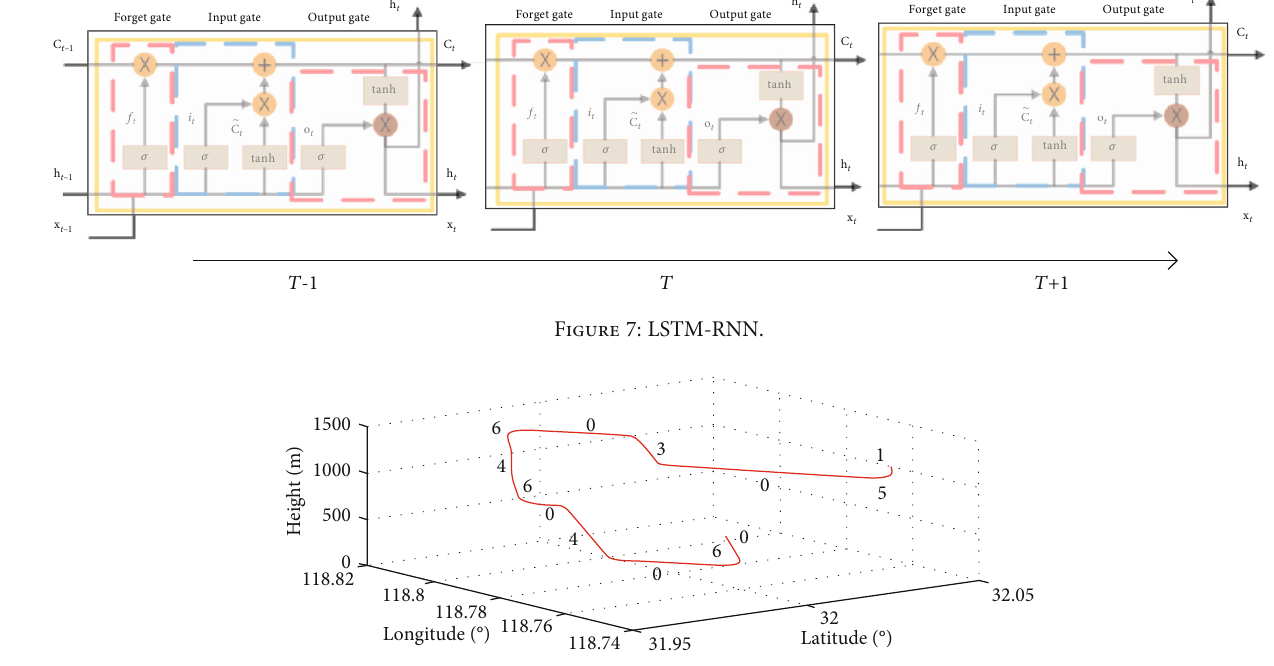
Figure 7: LSTM-RNN.